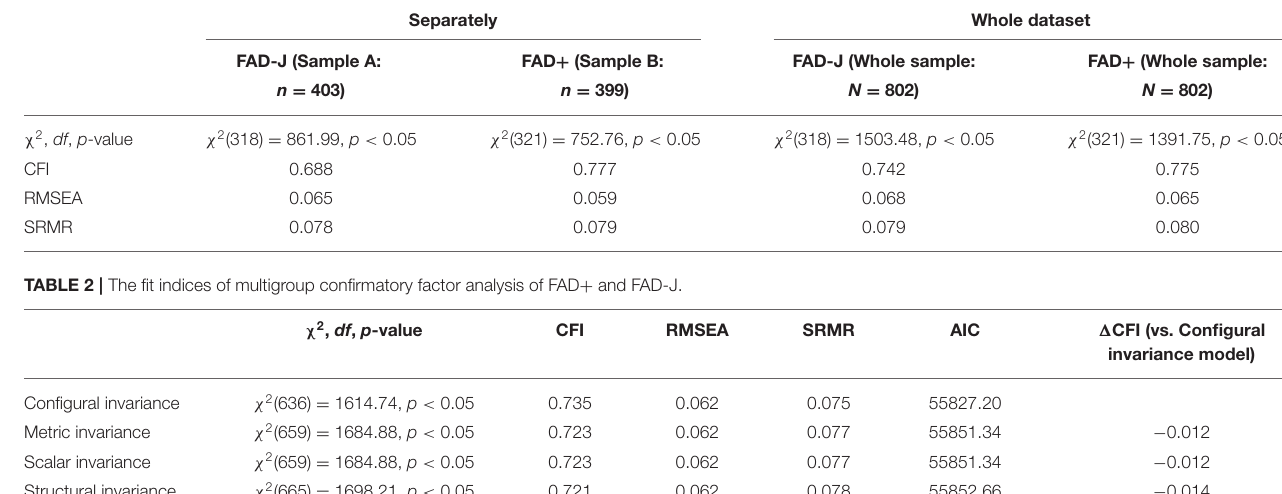
TABLE 1 | The fit indices of confirmatory factor analysis of FAD + and FAD-J. Separately Whole dataset FAD-J (Sample A: FAD + (Sample B: FAD-J (Whole sample: FAD + (Whole sample: n = 403) n = 399) N = 802)